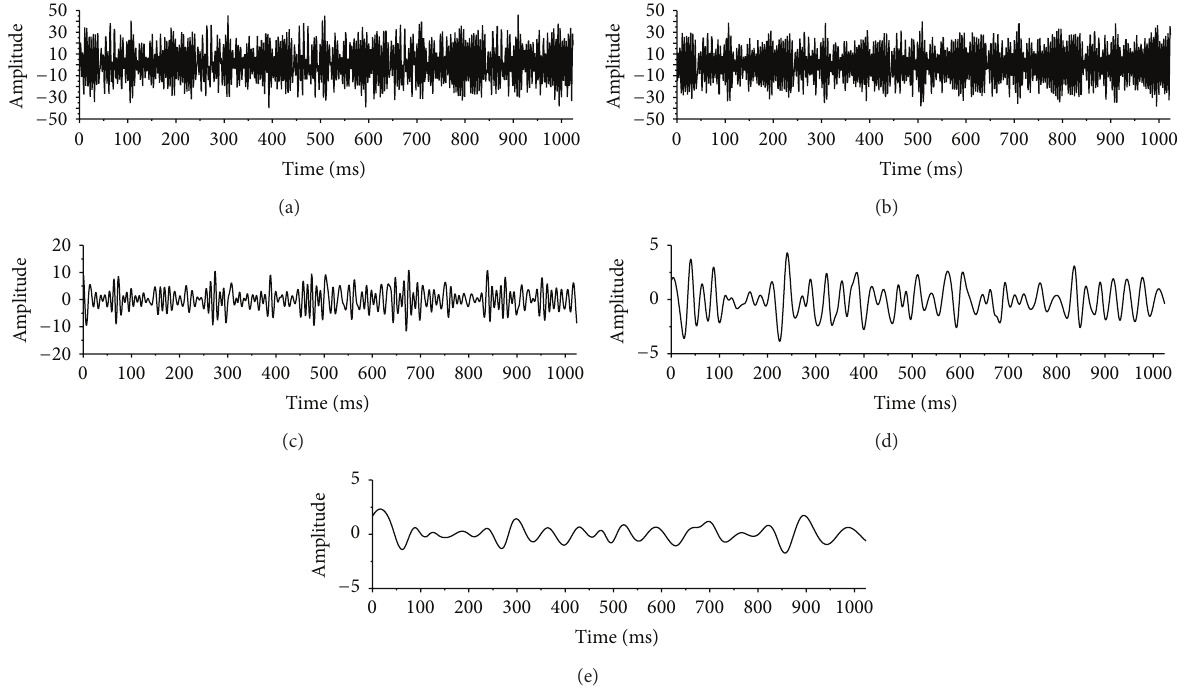
Figure 19: Outer ring fault signal and